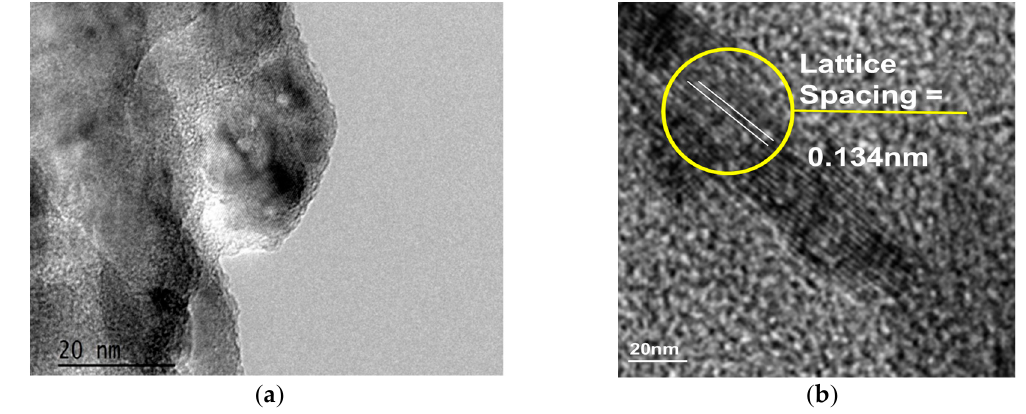
Figure 3. TEM images of the samples deposited from ( a ) methane on copper substrate, and ( b ) bagasse on porous nickel substrate.